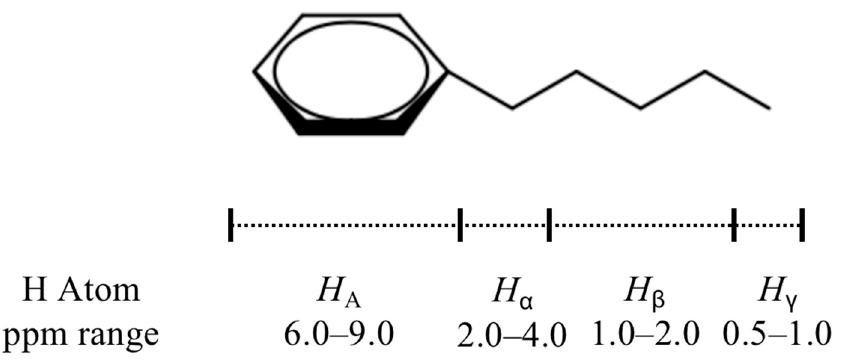
Figure 4. Hydrogen atoms are divided into four categories and the corresponding ppm range on NMR spectroscopy for each category. NMR spectroscopy for each